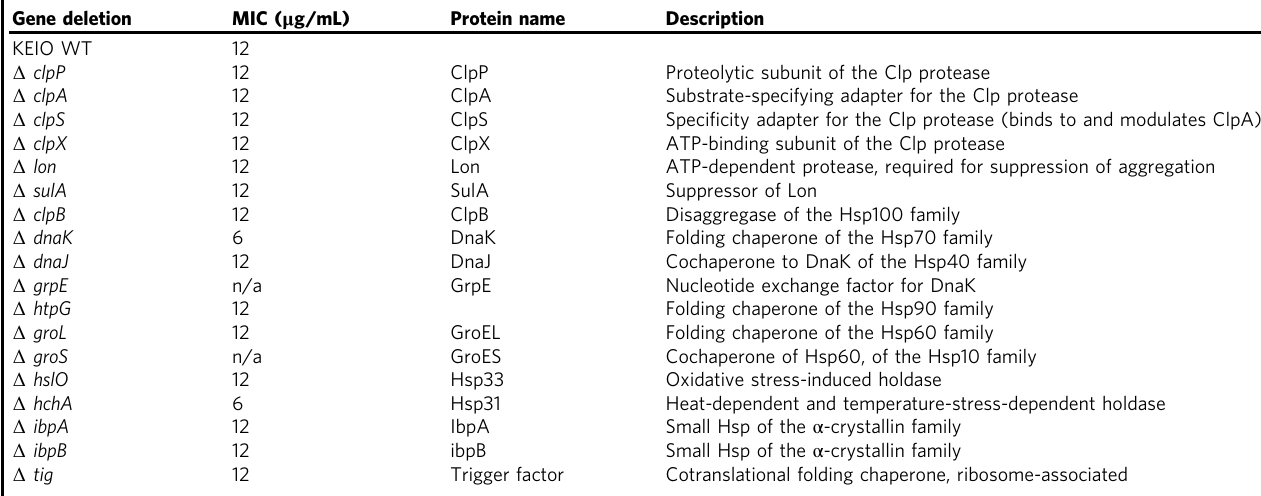
Table 2 MIC of P2 for chaperone deletion strains Gene